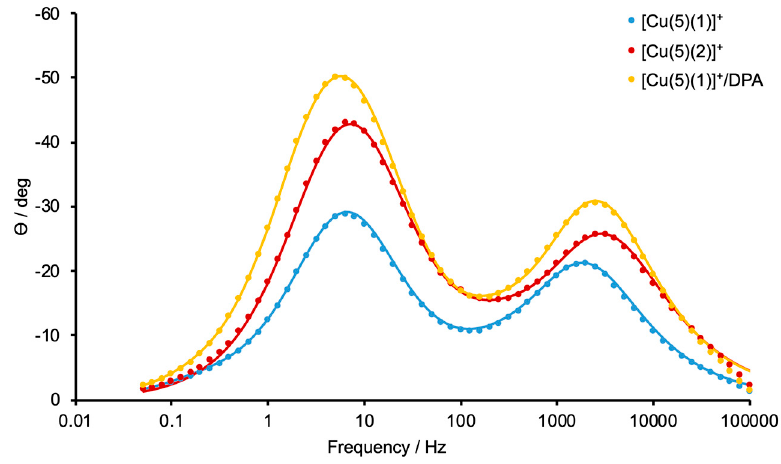
Figure 16. Bode plots of the DSCs containing dyes [Cu( 5 )( 1 )] + and [Cu( 5 )( 2 )] + , and [Cu( 5 )( 1 )] + with the co-adsorbent DPA. Solid lines represent fitted curves and the solid-circles represent experimental data.